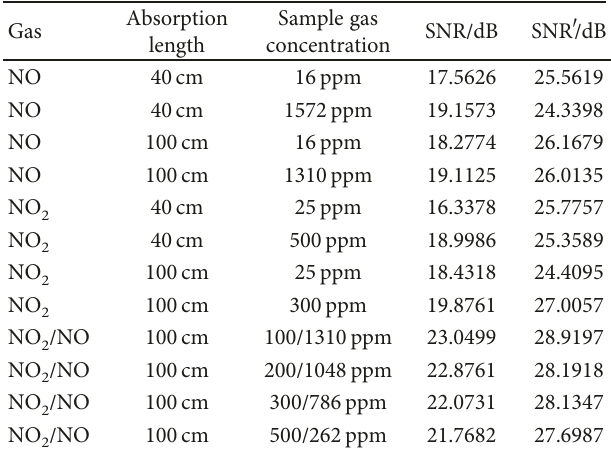
Figure 4: Three NO spectra before and after denoising with NIO EEMD. X Table 1: SNR of NO spectra of di ff erent concentrations before and X after